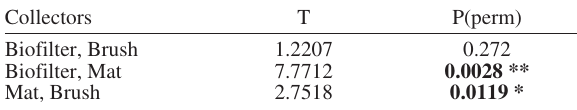
Table S4. – Pairwise comparisons for the significant factors ‘Col- lector’ obtained in the permutational analysis of variance (PER- MANOVA) assessing differences in number of A. lixula settlers/m 2 collected at Abades in February 2012. Differences in settlers